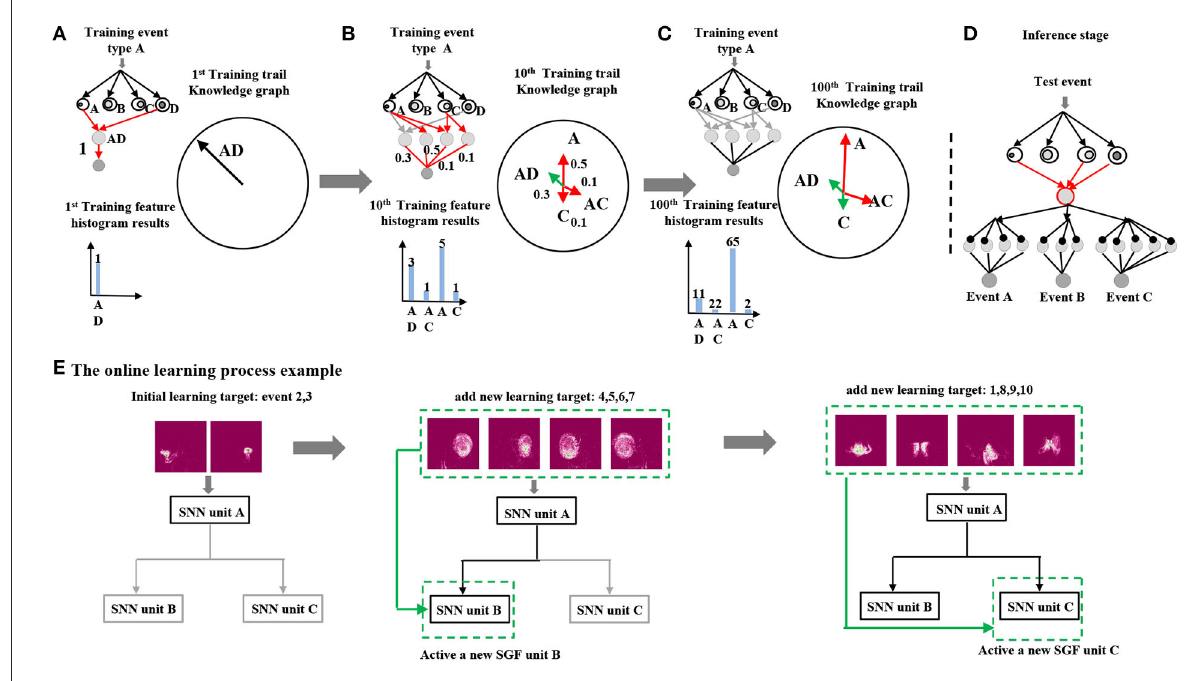
FIGURE3 (A–D) The histogram-based training example of an event type A. (E) An example of the system online learning process.